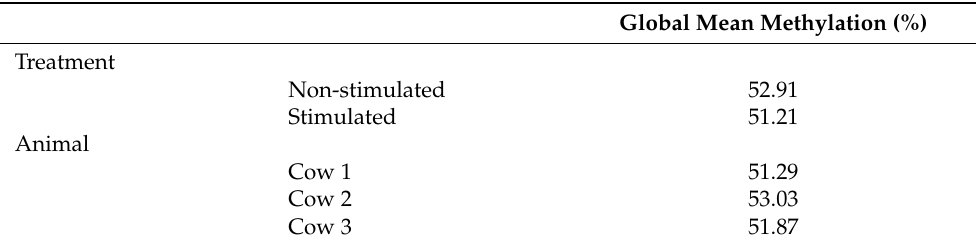
Table 1. Global mean DNA methylation percentages of single cell oocyte libraries grouped by treatment (non-stimulated and stimulated) and by animal (Cow 1, Cow 2, and Cow 3).